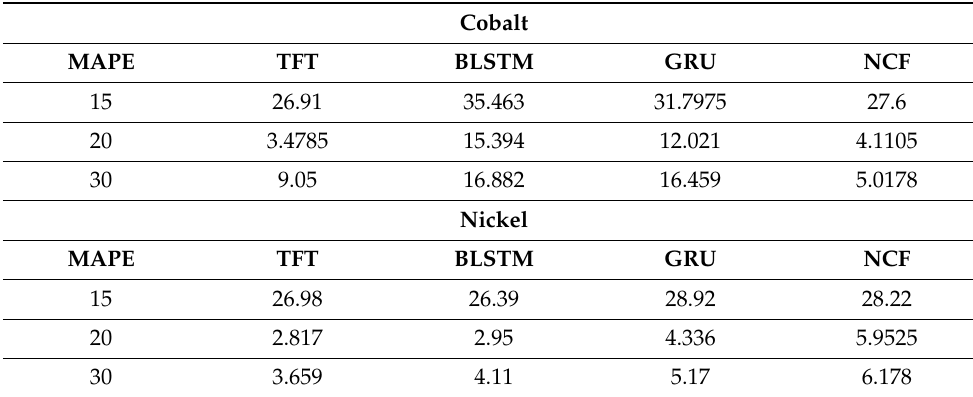
Table 3. MAPE values of forecasting accuracy of the used